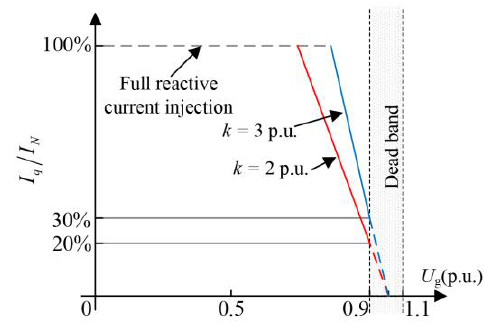
Figure 5. Reactive power configuration during LVRT.